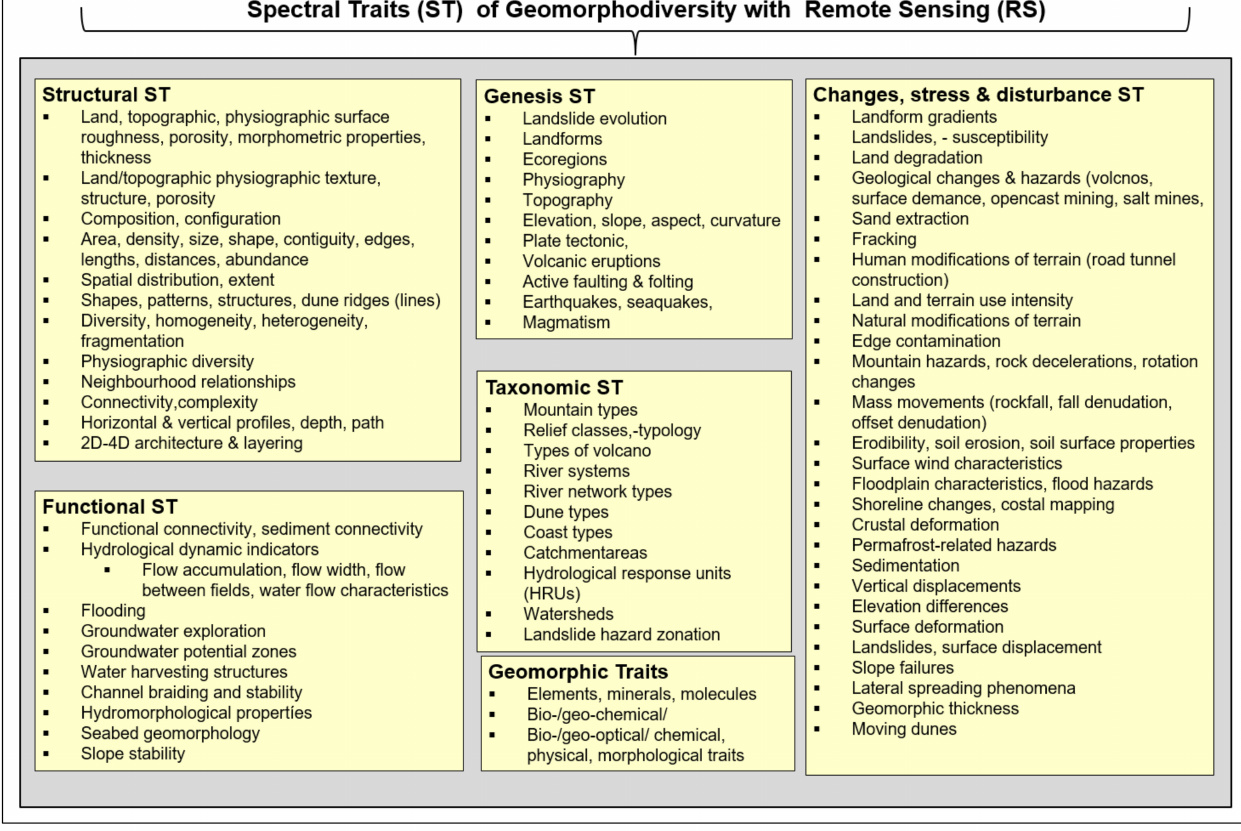
Figure 6. Examples of spectral traits of geomorphodiversity, monitored by RS